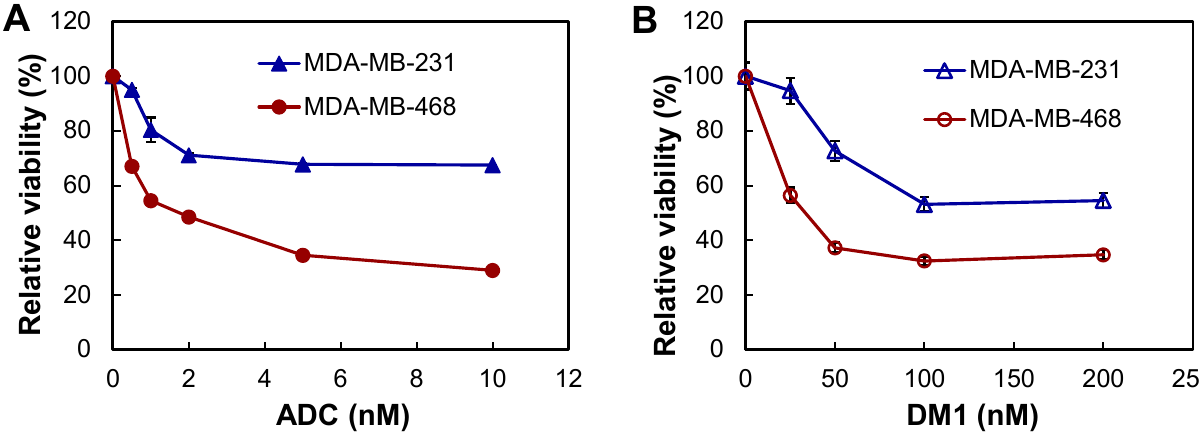
Figure 5. In vitro anti-TNBC cytotoxicity analysis of anti-CD47 ADC ( A ) and free drug DM1 ( B ). • : MDA-MB-468, and (cid:78) : MDA-MB-231. Data represent mean ± SEM, n = 3.